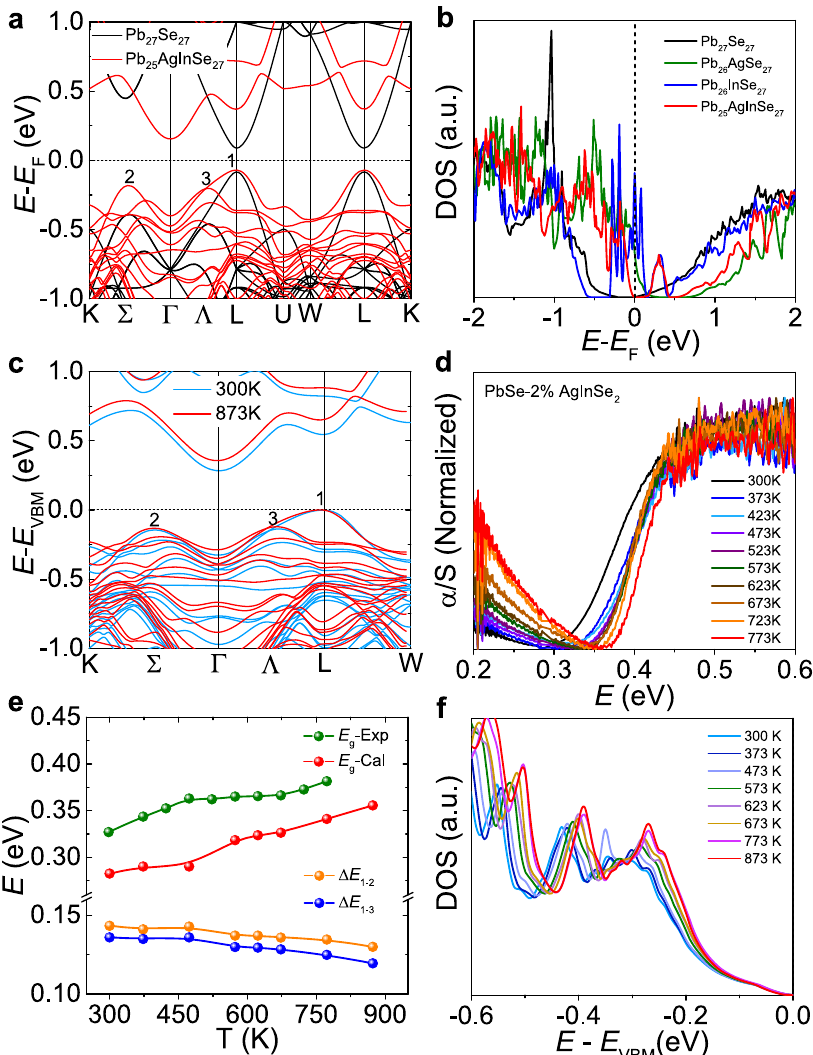
Fig. 5 Electronic band structure. a Electronic band structure of Pb 27 Se 27 (black) and Pb 25 AgInSe 27 (red). b Electronic density of states (DOS) near the Fermi level for Pb 27 Se 27 (black), Pb 26 AgSe 27 (green), Pb 26 InSe 27 (blue) and Pb 25 AgInSe 27 (red), respectively. c Electronic band structure of Pb 25 AgInSe 27 at 300 K and 873 K, respectively. d Temperature-dependent infrared spectra of PbSe − 2% AgInSe 2 . e The experimental (green) and theoretical (red) bandgap ( E g ) and the theoretical energy offset between VBM1 and VBM2 ( Δ E 1-2 ) and between VBM1 and VBM3 ( Δ E 1-3 ) as a function of temperature. f Temperature-dependent electronic DOS of Pb 25 AgInSe 27 near the